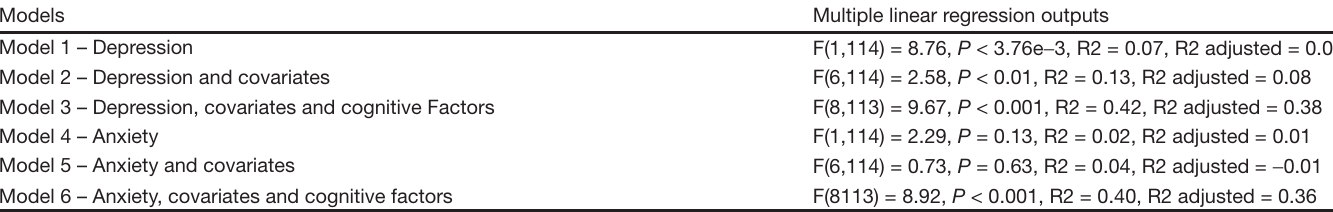
Table 5. Multiple linear regression outputs